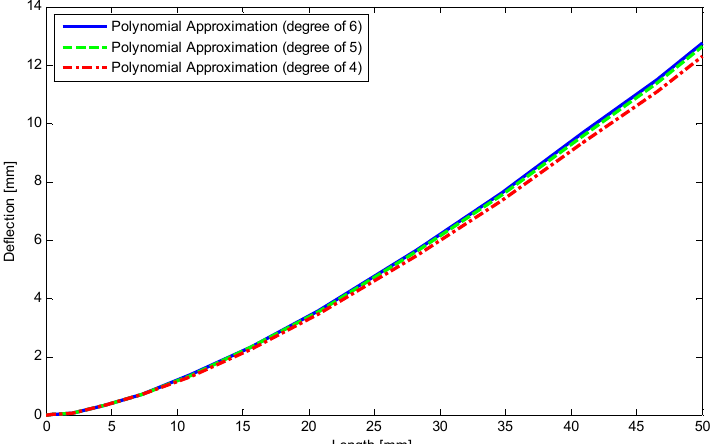
Figure 18. Comparison of different degrees of polynomial approximation function for deflection of SMA beam along the length.